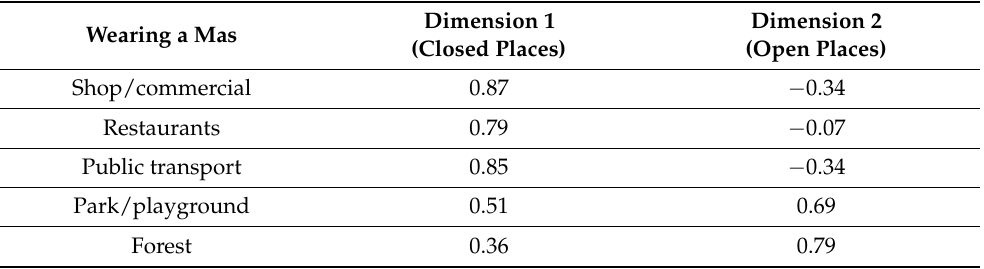
Table 2. Factor loadings for the first two principal components of face and nose covering in various places.